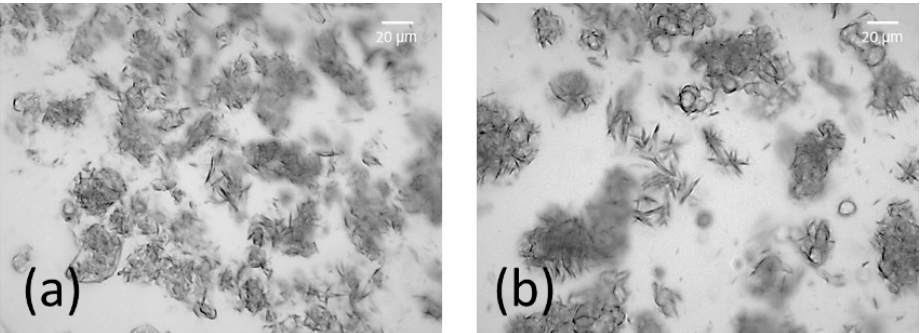
Figure 6. Visible light microscopy images of anti-CD20 crystals obtained using batch mode: ( a ) after three days under static conditions, and ( b ) after the seventh day under stirring conditions.